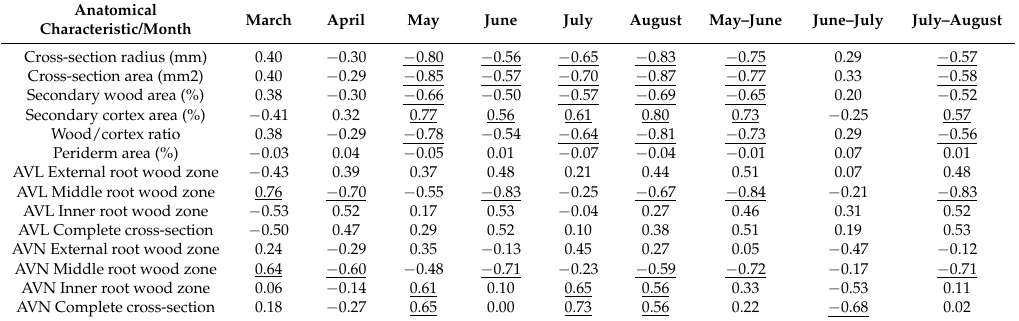
Table 5. Correlation coefficients of investigated anatomical characteristics and a number of dry days with precipitation less than 5 mm (PPT <5mm ) observed monthly and continuously trough vegetation.